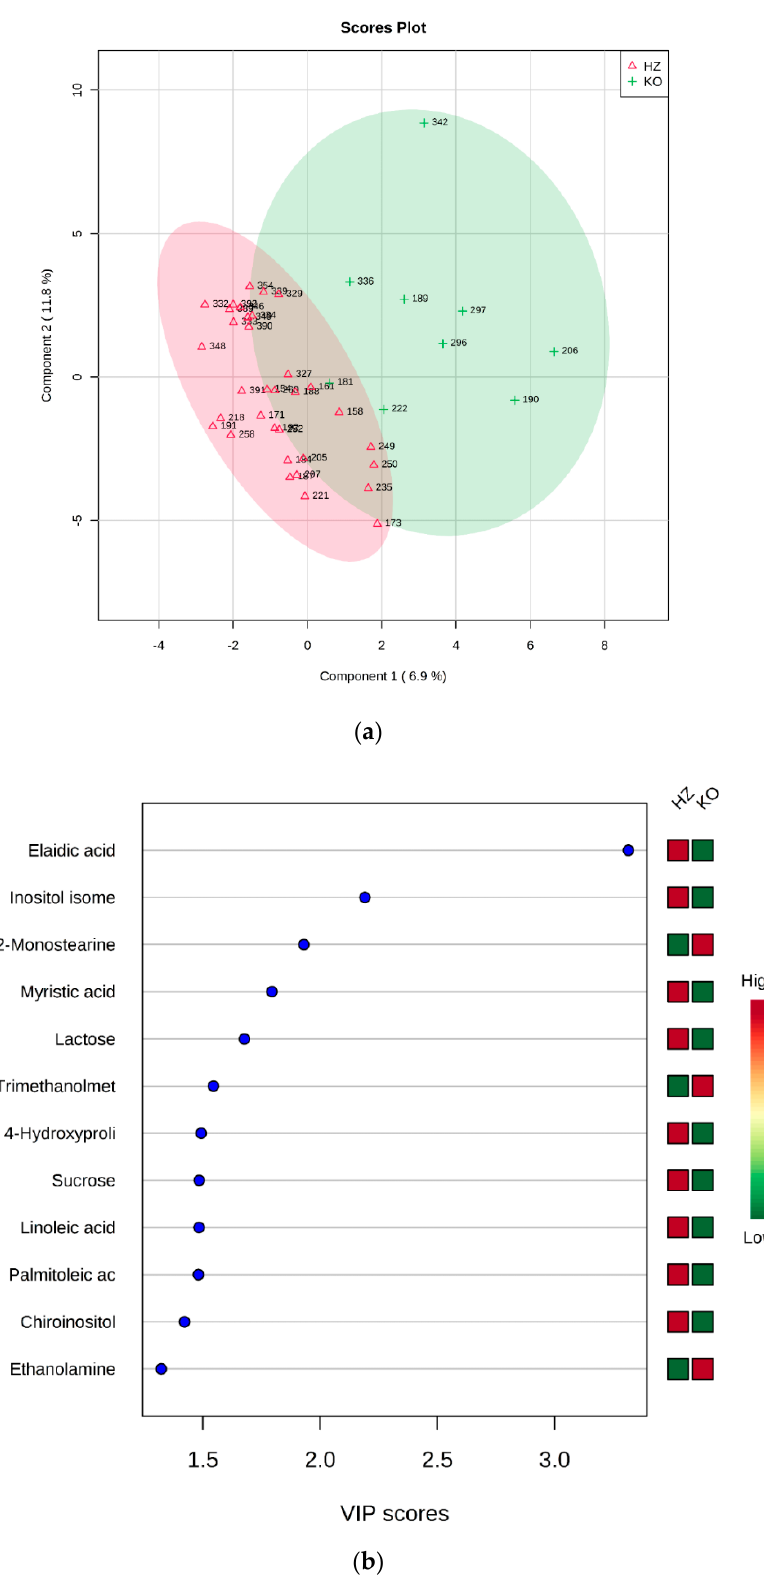
Figure 3. PLS-DA analysis of HZ vs. KO. ( a ) 2D scores plot, and ( b ) the corresponding VIP score plot (score > 1.0).